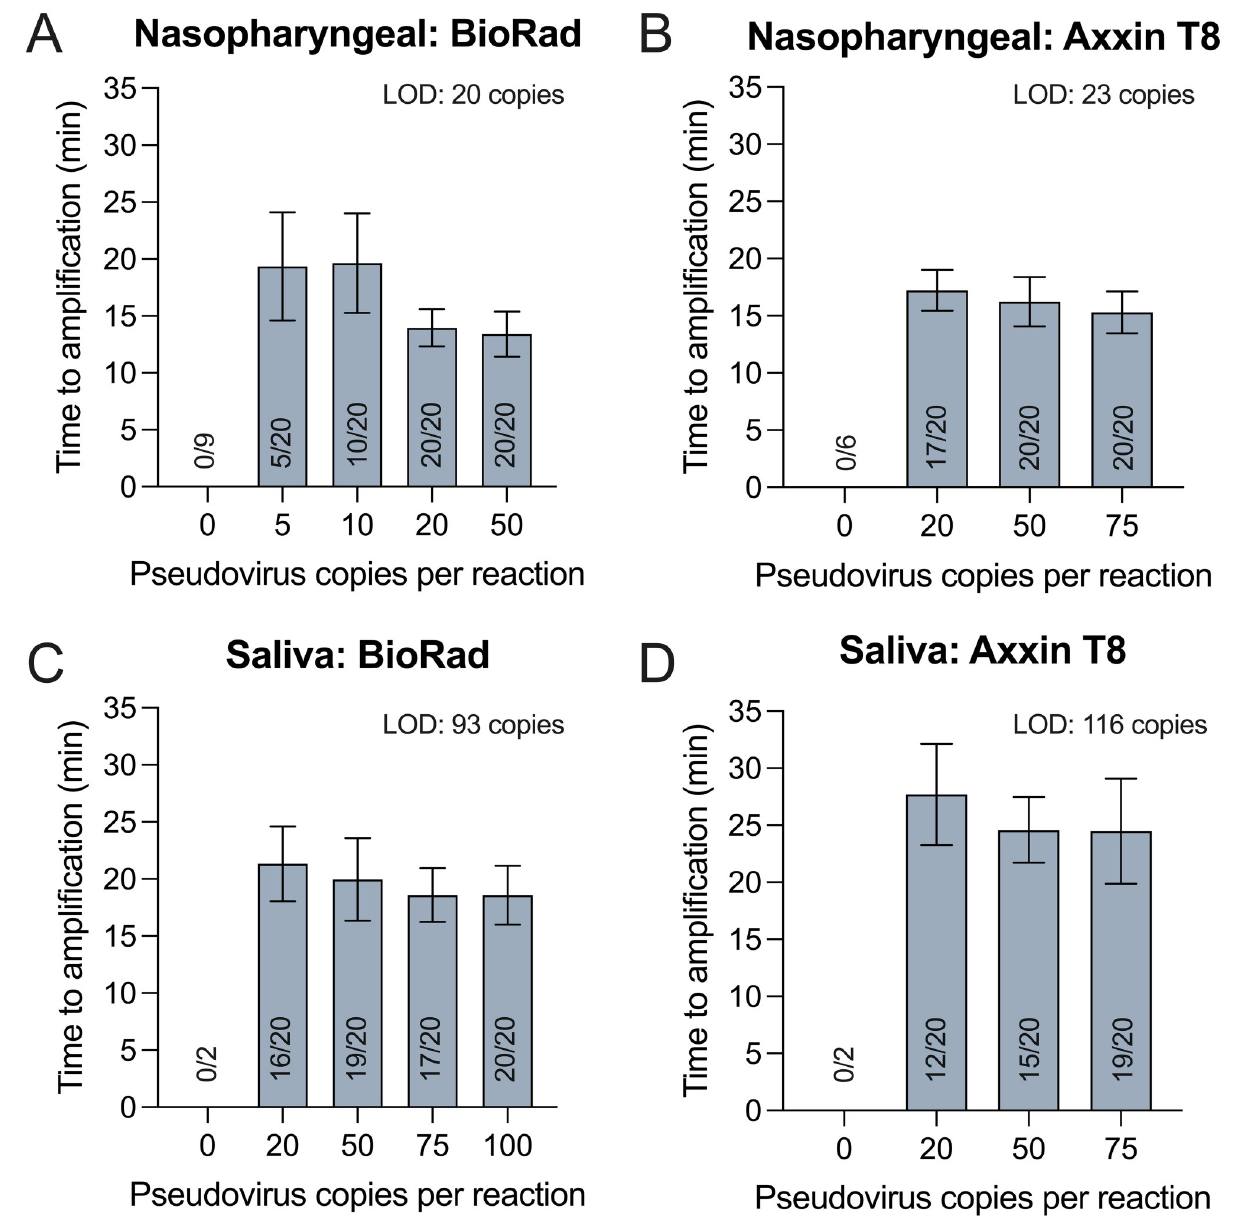
Fig 3. Limit of detection in negative pooled matrix. The limit of detection was assessed by spiking Zeptometrix pseudovirus into pooled nasopharyngeal matrix collected in lysis buffer that had previously tested negative for SARS-CoV-2 in RT-qPCR using the CDC assay, or negative pooled saliva combined with lysis buffer. Samples were heat-inactivated at 95˚ C for 5 minutes (A,B) or 6 minutes (C,D), and tested on either the Bio- Rad CFX96 or Axxin T8. The limit of detection at 95% probability was determined using probit analysis to be: (A) 20 copies per reaction on the Bio-Rad CFX96 and (B) 23 copies per reaction on the Axxin T8 for nasopharyngeal samples. The limit of detection in saliva was found to be: (C) 93 copies per reaction on the Bio-Rad CFX96 and (D) 116 copies per reaction on the Axxin